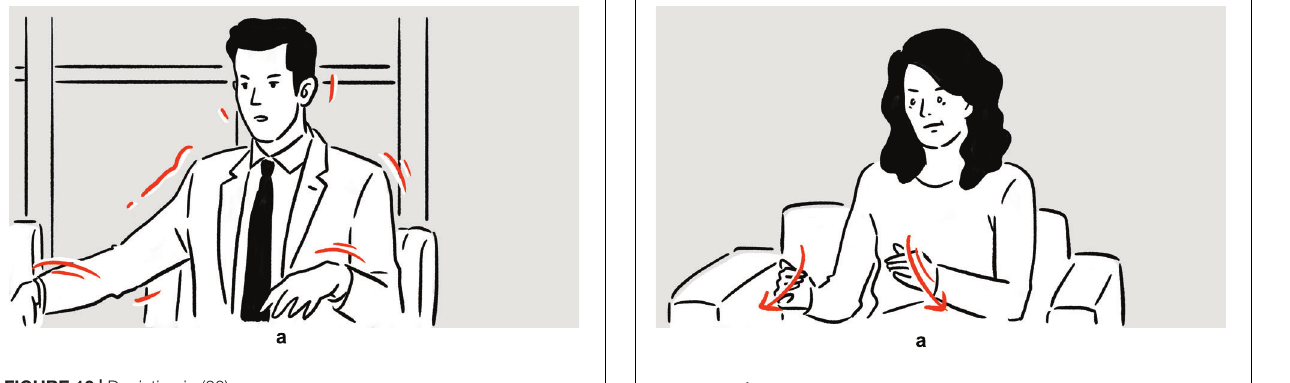
FIGURE 12 | Depiction in (20). FIGURE 13 | Depiction in